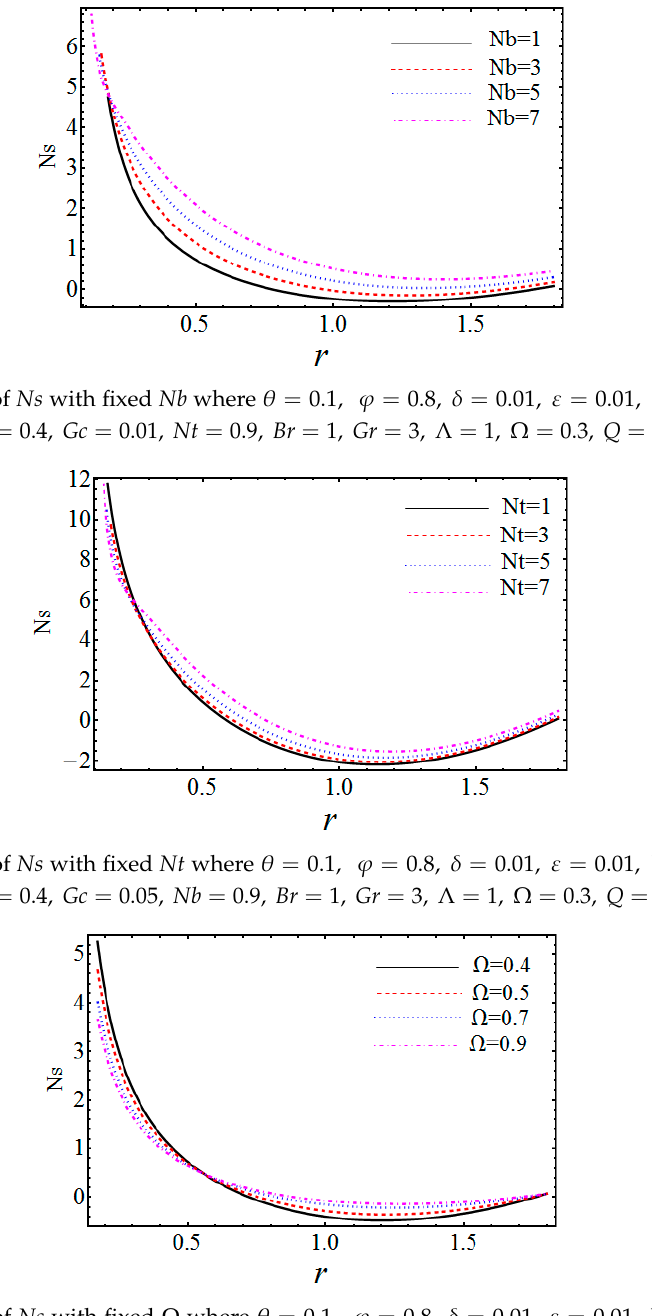
Figure 17. Curves of 𝑁𝑠 with fixed Γ where 𝜃 = 0.3, 𝜑 = 0.8,𝛿 = 0.01, 𝜀 = 0.01, 𝑉 = 0.3, 𝜆 (cid:2869) = 1, 𝑧 = 0, 𝑡 = 0.1, Ω = 0.3, 𝐺𝑐 = 0.01, 𝑁𝑡 = 0.5, 𝐵𝑟 = 1, 𝐺𝑟 = 3,Λ = 0.4,𝑁𝑏 = 0.9,𝑄 = 1. Figure 18. Curves of 𝑁𝑠 with fixed Λ where 𝜃 = 0.3, 𝜑 = 0.8,𝛿 = 0.01, 𝜀 = 0.01, 𝑉 = 0.3, 𝜆 (cid:2869) = 1, 𝑧 = 0,𝑡 = 0.1,Ω = 0.3, 𝐺𝑐 = 0.01,𝑁𝑡 = 0.5,𝐵𝑟 = 1,𝐺𝑟 = 3, Γ = 0.4,𝑁𝑏 = 0.9,𝑄 = 1. Figures 19–22 are established to show the effects of physical factors on Bejan number 𝐵𝑒 , which is the ratio of two entropy generations. Figure 19 elucidates that the increase in 𝐺𝑐 imposes an increase in Bejan number, which reflects the aspect that entropy due to heat transfer is less than that of total entropy in the lower region, but totally inverse readings are noted in the rest of the space. With the growing effects of Ω , Bejan number 𝐵𝑒 enhances through the flow domain, which can be found in Figure 20. From Figures 21 and 22 it is evident that 𝐵𝑒 decreases with increments in Γ and Λ, which indicates that the total entropy leads the same because of heat irreversibility.